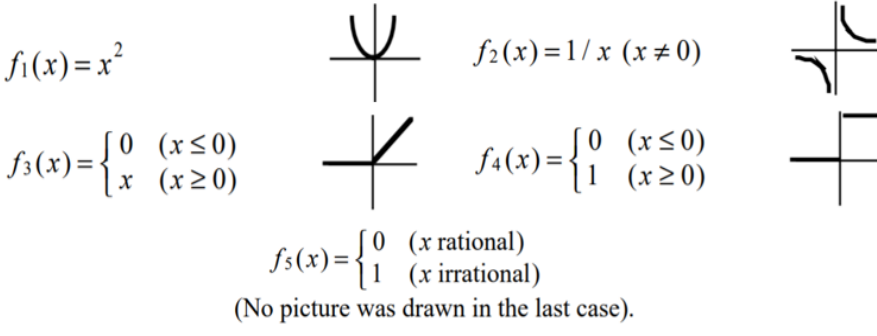
Figure 3.1 Images from Tall and Vinner,